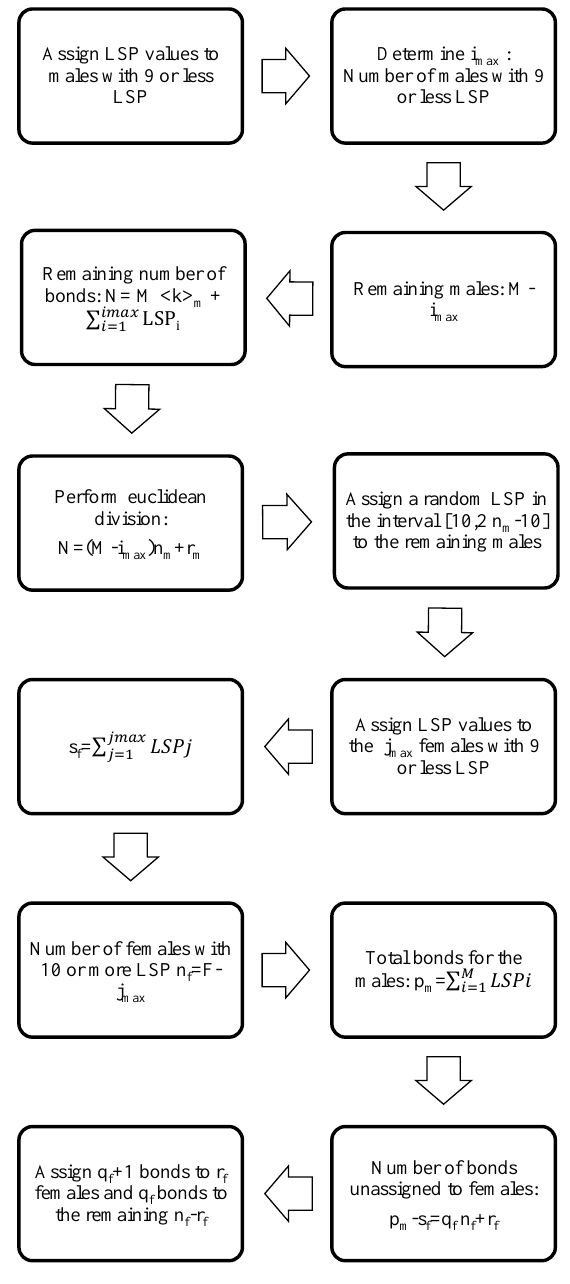
Figure 1. Flow diagram for the algorithm corresponding to the assignment of a number of LSPs to every male and female in the